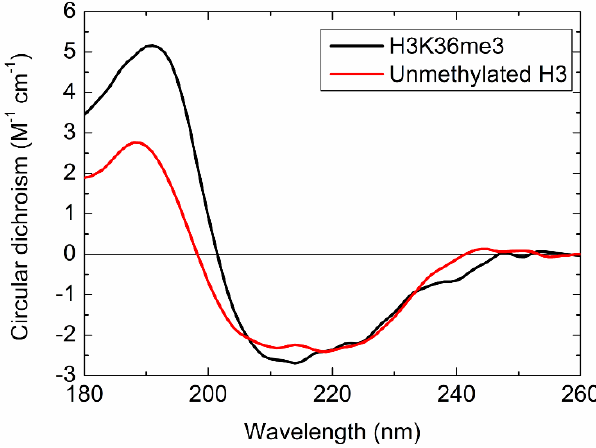
Figure 7. CD spectra of H3K36me3 (black) and unmethylated H3 (red), reproduced from literature data [36].